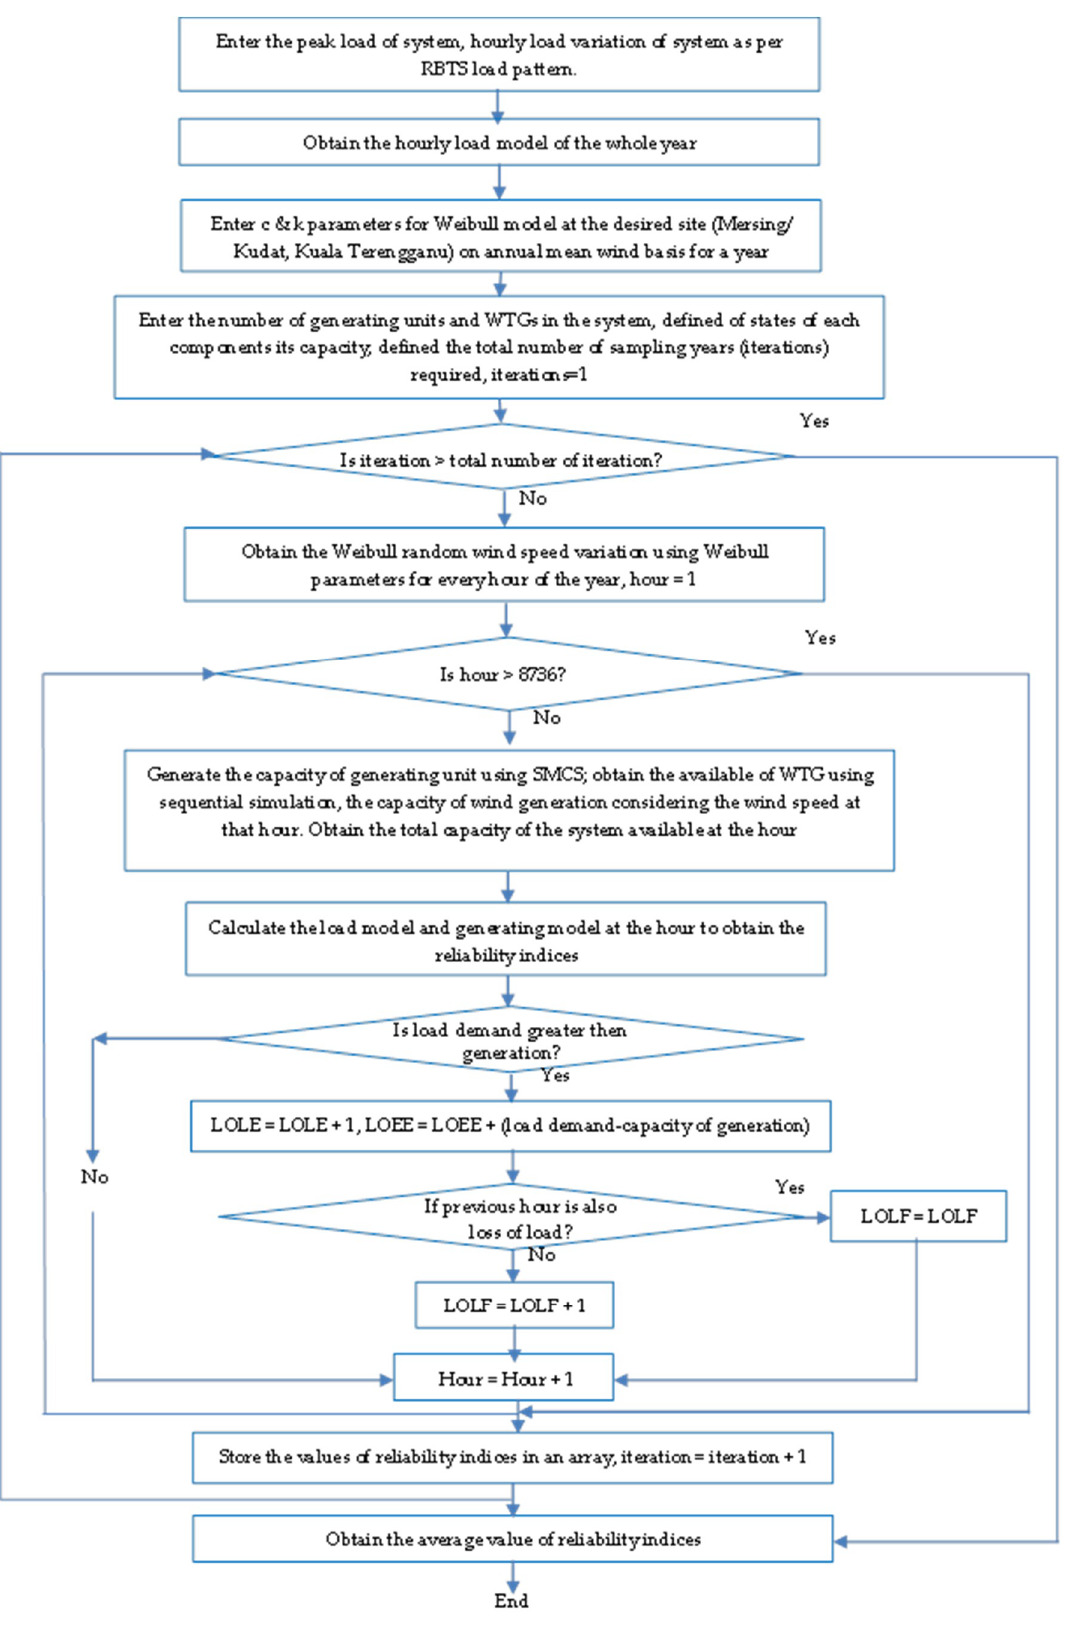
Figure 3. Flow chart showing reliability assessment for a generation system including wind generating sources.